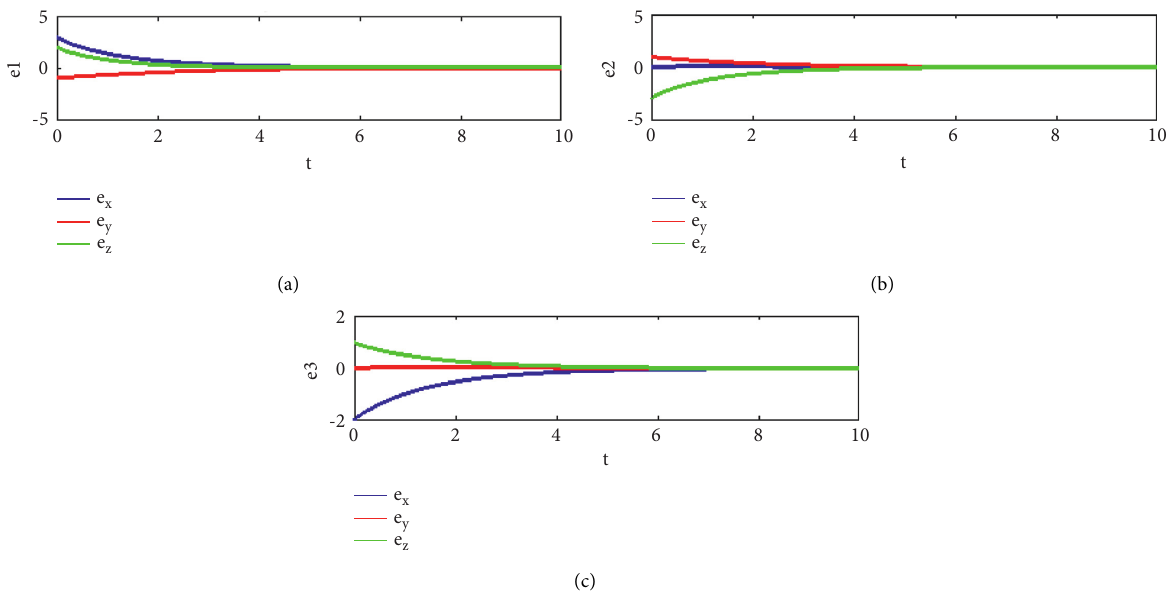
Figure 2: The error trajectories of leader and agents with c � − 0 . 1 in Example 1. (a) The error trajectories of v0 and v1. (b) The error trajectories of v0 and v2. (c) The error trajectories of v0 and